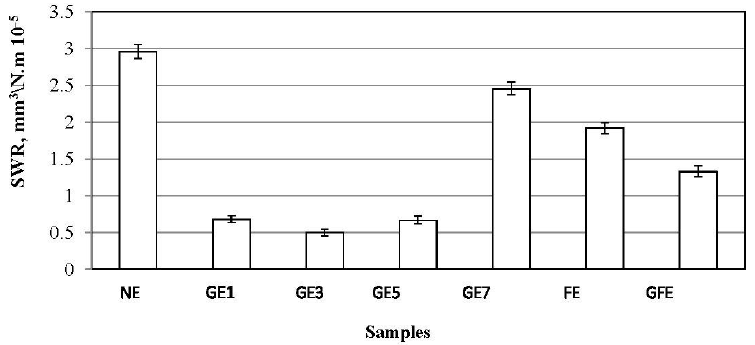
Figure 2. Specific wear rate of the filler/epoxy composites after a 7.5-km sliding